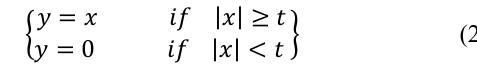
Figure 4: The modeled (a) and received (b) chest wall motion The range profile evaluation is the step before the WT. After obtaining the range profile, WT, thresholding and the inverse WT steps are carried out and the noise removal operation is finalized. The denoising process of a SFCW radar return signal is given in Figure 5.